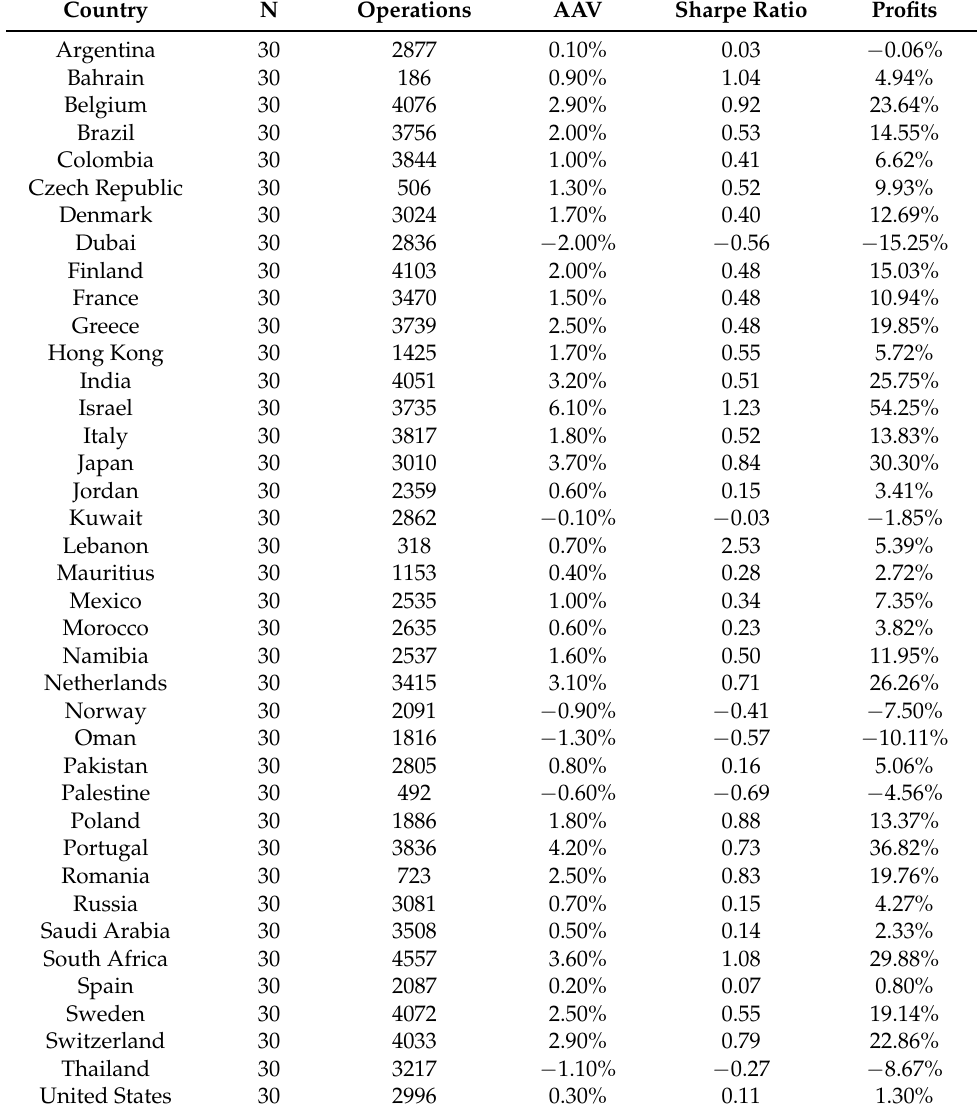
Table A5. Results obtained for the period 2007–2014 (30 Pairs), where N is the number of pairs; AAV Average annualized return; and Profit is the profitability for the full period with transaction costs.